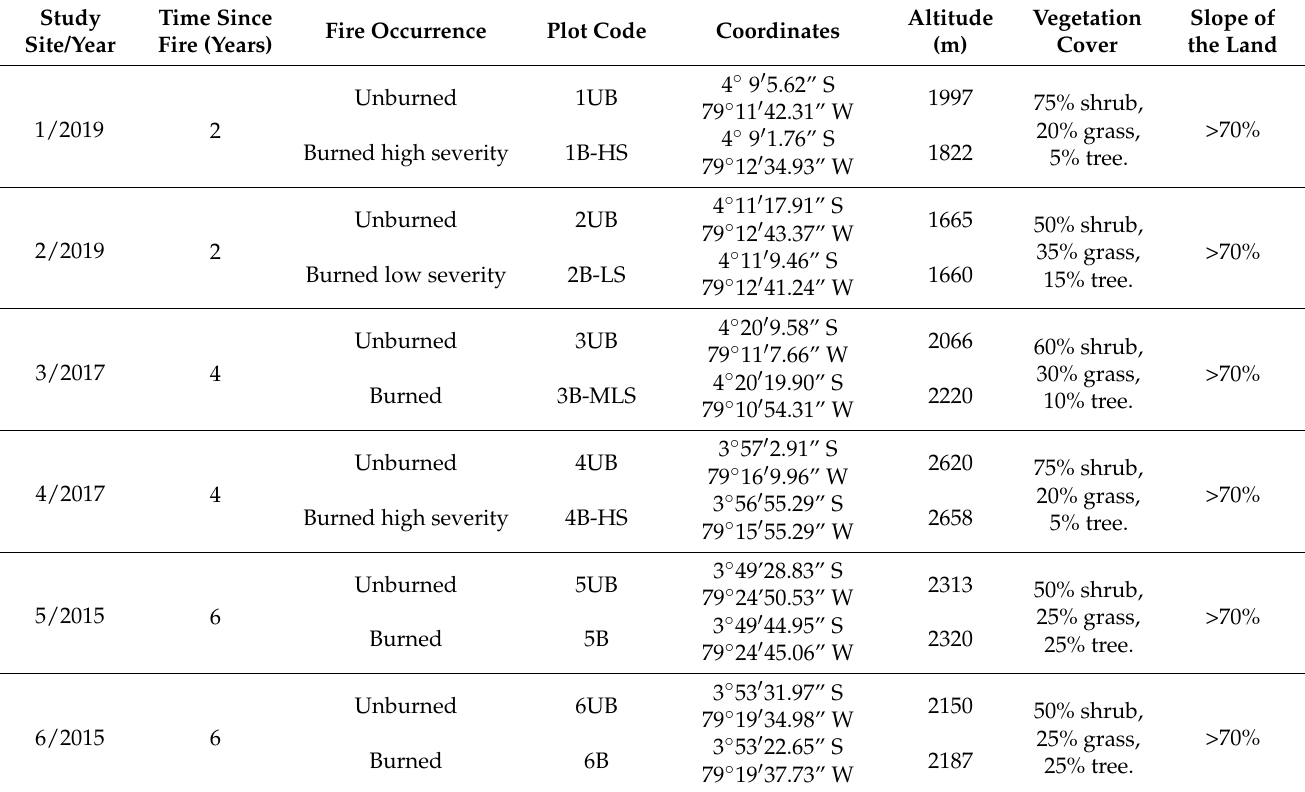
Table 1. Main characteristics of the studied sites with HMs of Loja canton, southern